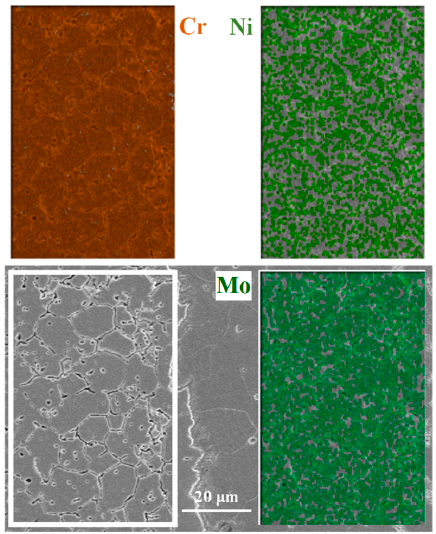
Figure 4. SEM image and EDS analysis of the selected area in the rolled material.